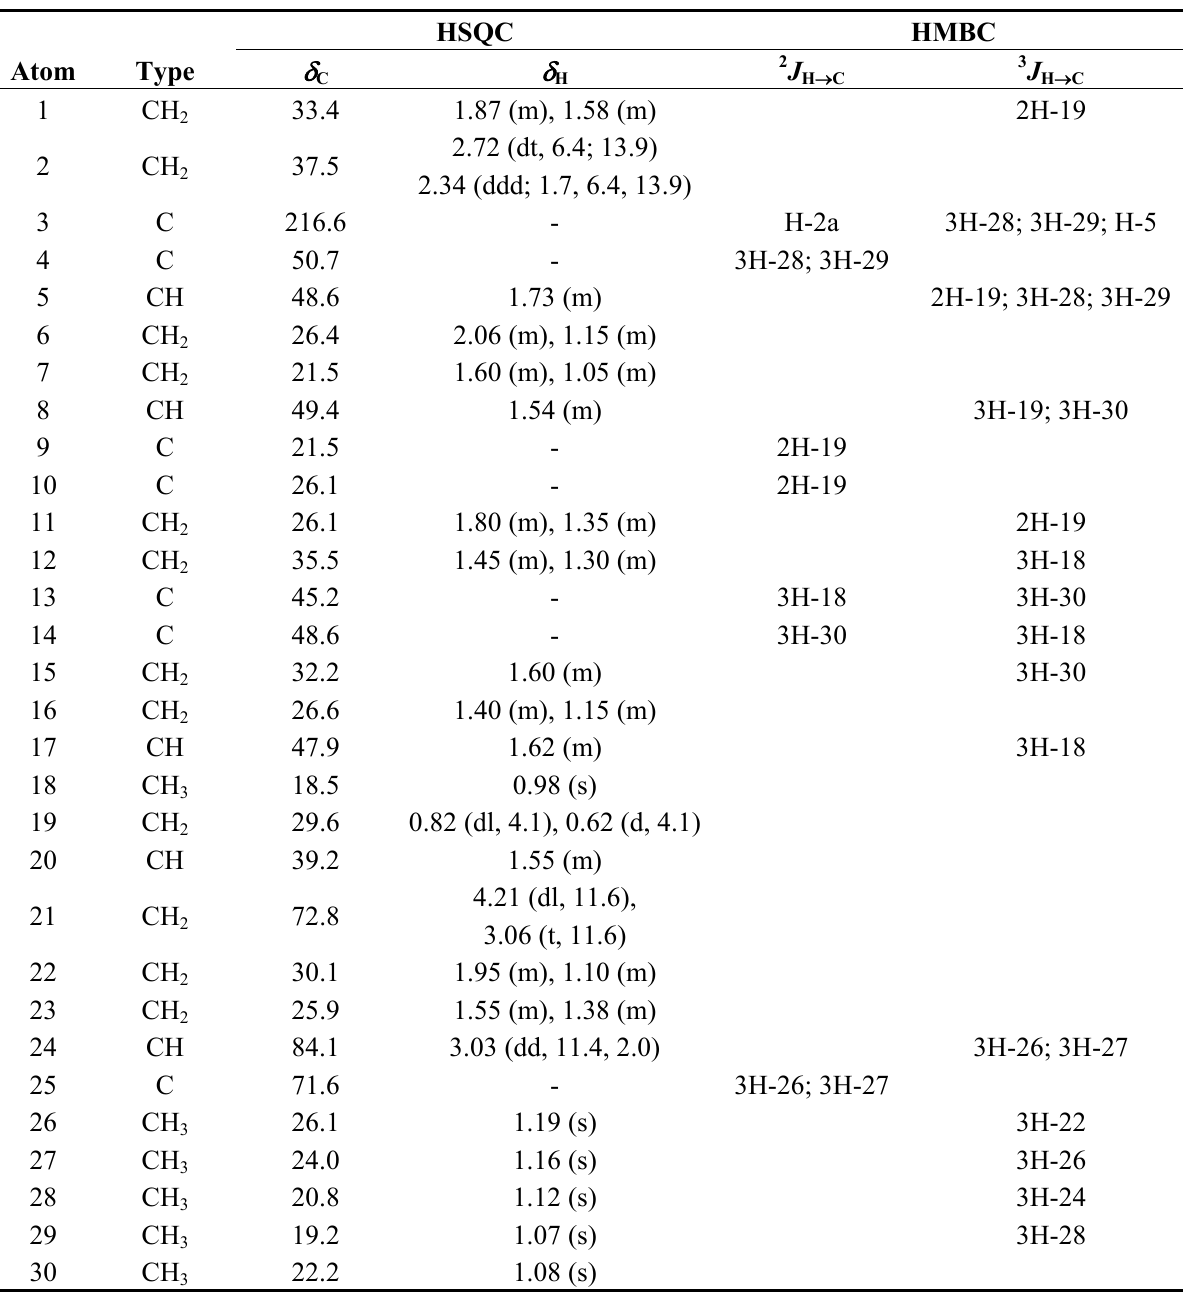
Table 1. 1 H- (500 MHz) and 13 C- (125 MHz) NMR of hirtinone ( 1 ), including results obtained by heteronuclear 2D shift-correlated HSQC and HMBC, in CDCl TMS used as internal reference. Chemical shifts (  , ppm) and coupling constants ( J , Hz, in parenthesis) *.